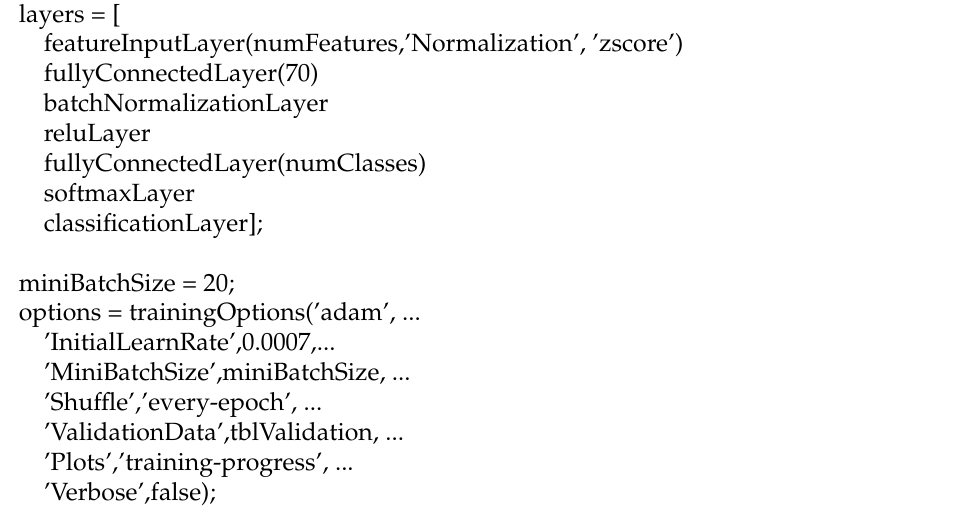
Algorithm 1 Neural Network Architecture and Training Options.